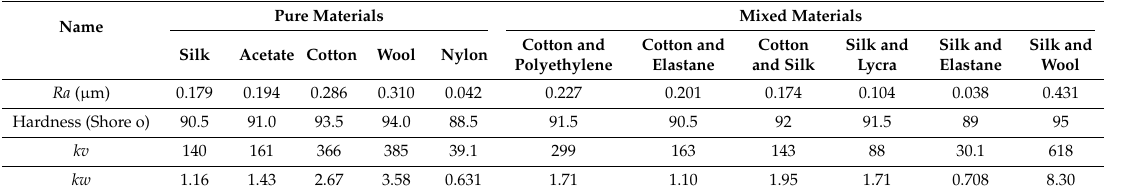
Table 2. Properties of fabric substrates as function of